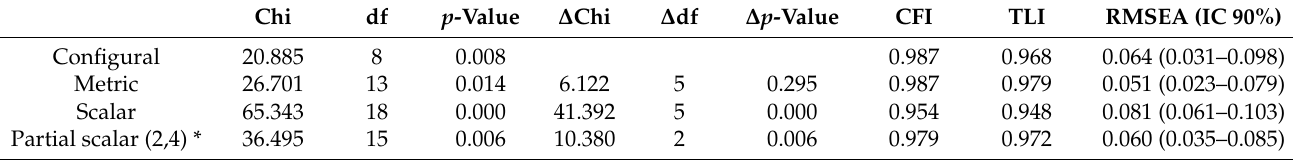
Table 2. Descriptive statistics and factor loading of confirmatory factor